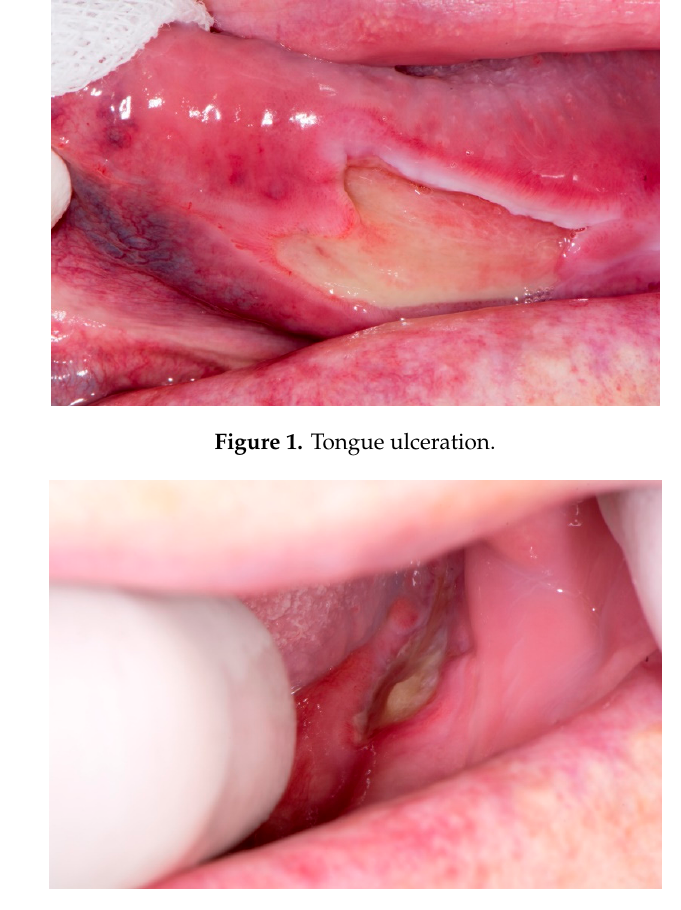
Figure 2. Exposed bone in distal part of the mandible.